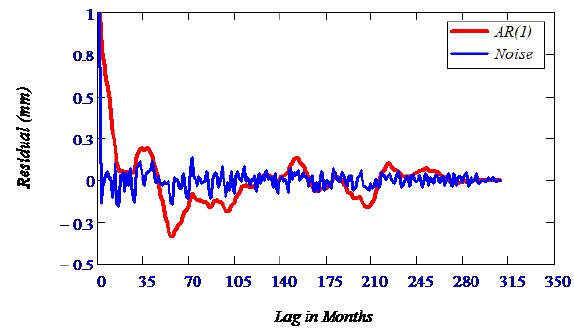
Fig. 4. Correlogram for AR(1) residuals and noise.